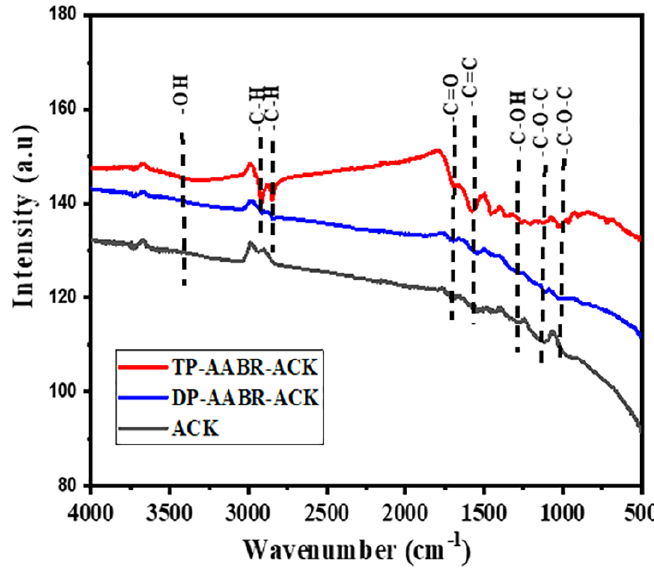
Figure 5. FTIR spectrum of ACK, DP-AABR-ACK, and TP-AABR-ACK composites.